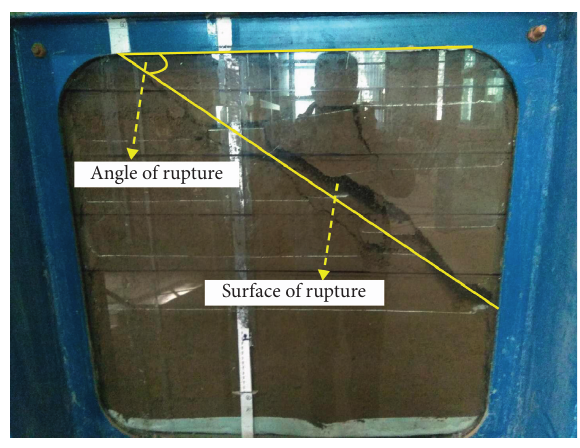
Figure 13: Model test soil rupture